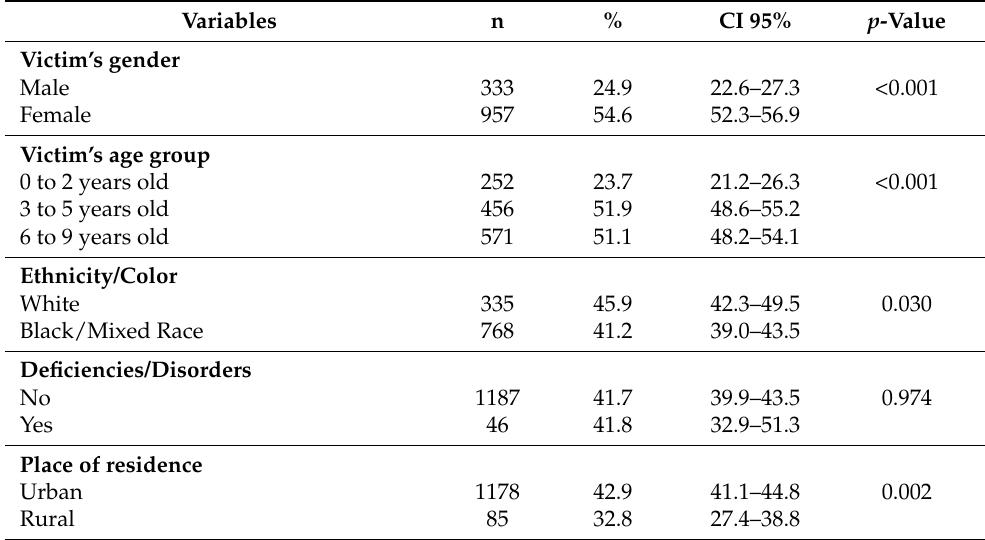
Table 2. Distribution of sexual violence perpetrated against child according to the characteristics of the victim, the offender and the offense. Esp í rito Santo, 2011 to